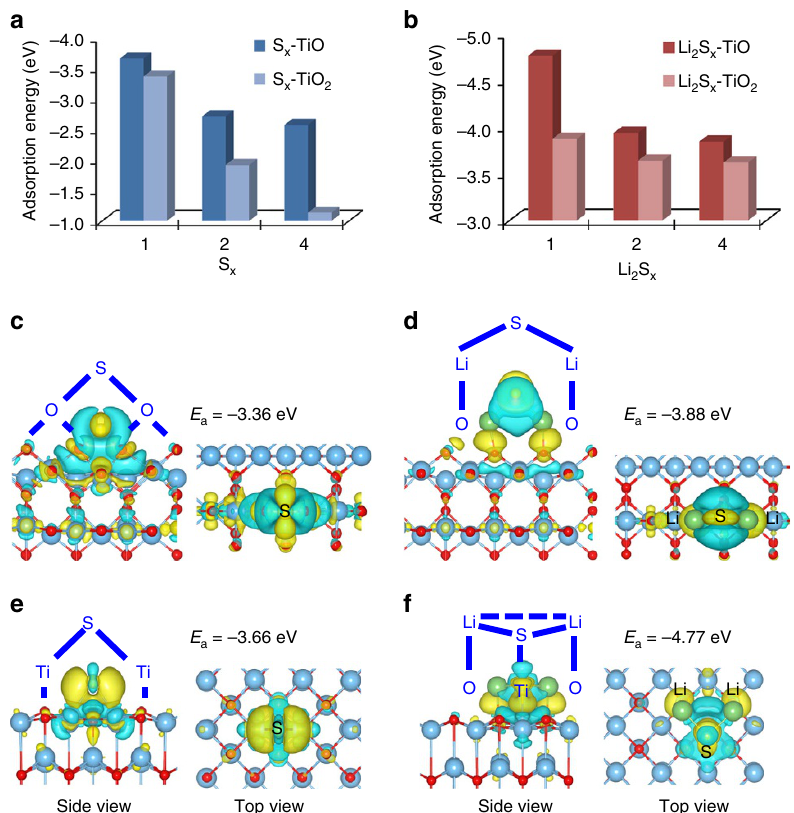
Figure 7 | DFT analysis of adsorption energies of S species on TiO (001) and TiO 2 (110). Adsorption energies for ( a ) S x and ( b ) Li 2 S x ( x ¼ 1, 2 and 4) compounds on TiO (001) and TiO 2 (110) surfaces. Isosurface of the charge density difference for ( c ) S and ( d ) Li 2 S adsorbed on TiO 2 (110), and ( e ) S and ( f ) Li 2 S adsorbed on TiO (001). Yellow surfaces correspond to charge gains and blue surfaces correspond to an equivalent charge lost. To make the plot clear, the isovalues are defined as 0.002 in all